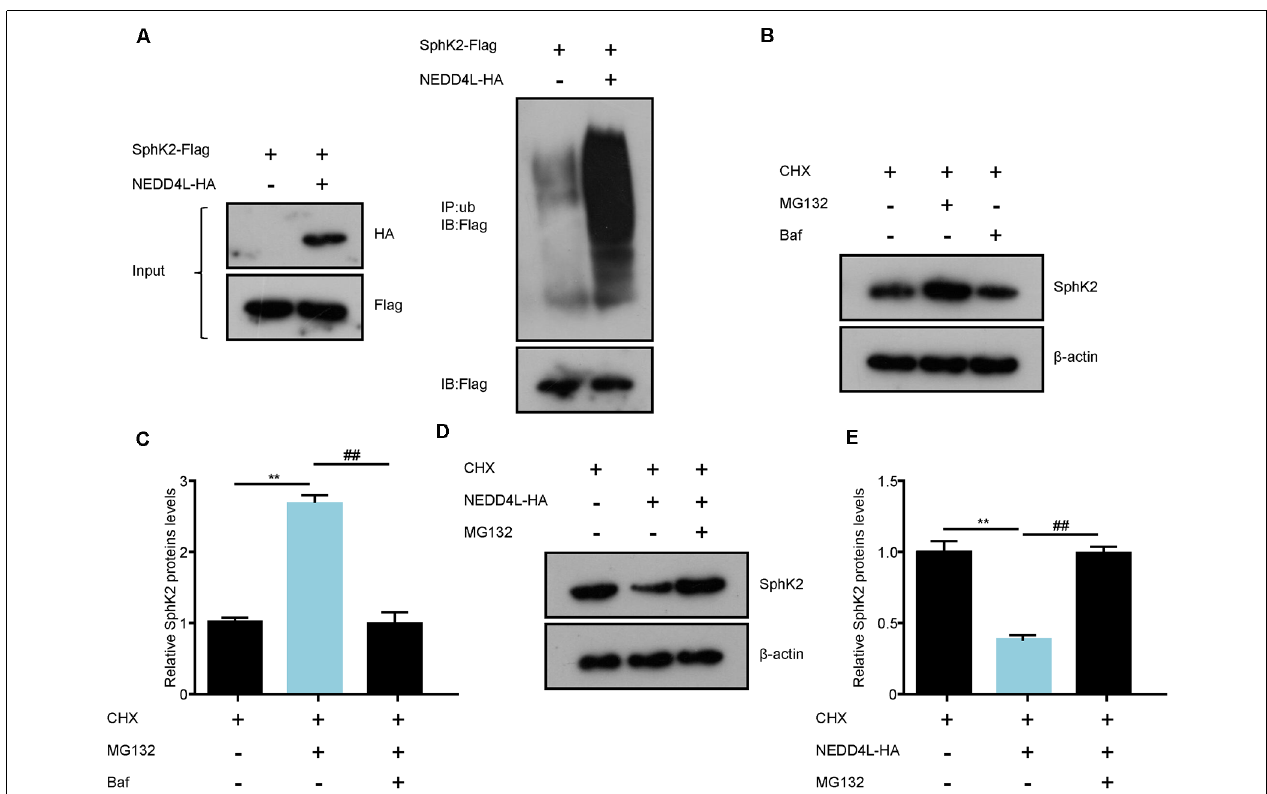
FIGURE 3 | NEDD4L ubiquitinates SphK2 protein and mediates its degradation. (A) HEK293T cells were transfected with SphK2-Flag and/or NEDD4L-HA overexpression plasmid and then SphK2 protein was immunoprecipitated by anti-Flag to detect its ubiquitination level. (B,C) BAF or MG132 treated HEK293T cells to explore the way how the SphK2 protein degraded. ** P < 0.01 compared with cycloheximide (CHX); ## P < 0.01 compared with CHX in combination with BAF. (D,E) HEK293T cells were transfected with NEDD4L-HA overexpression plasmid and/or MG132 and the levels of SphK2 protein were detected. ** P < 0.01 compared with CHX; ## P < 0.01 compared with CHX in combination with NEDD4L